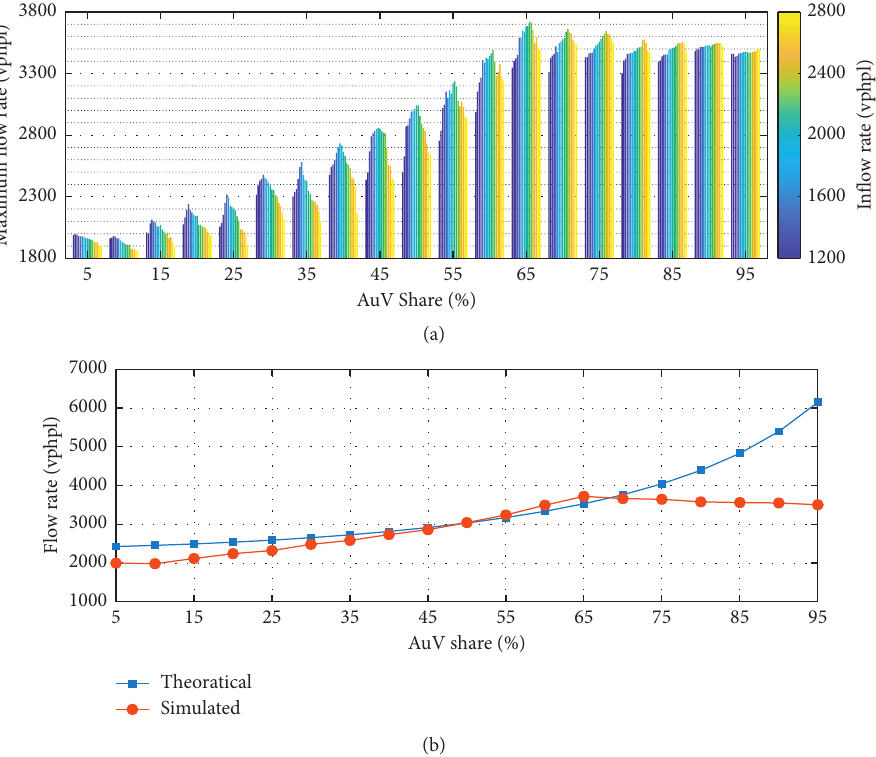
Figure 3: (a) Maximum flow rate through weaving section at various traffic state; (b) comparison between theoretical and simulated maximum flow rate for mixed